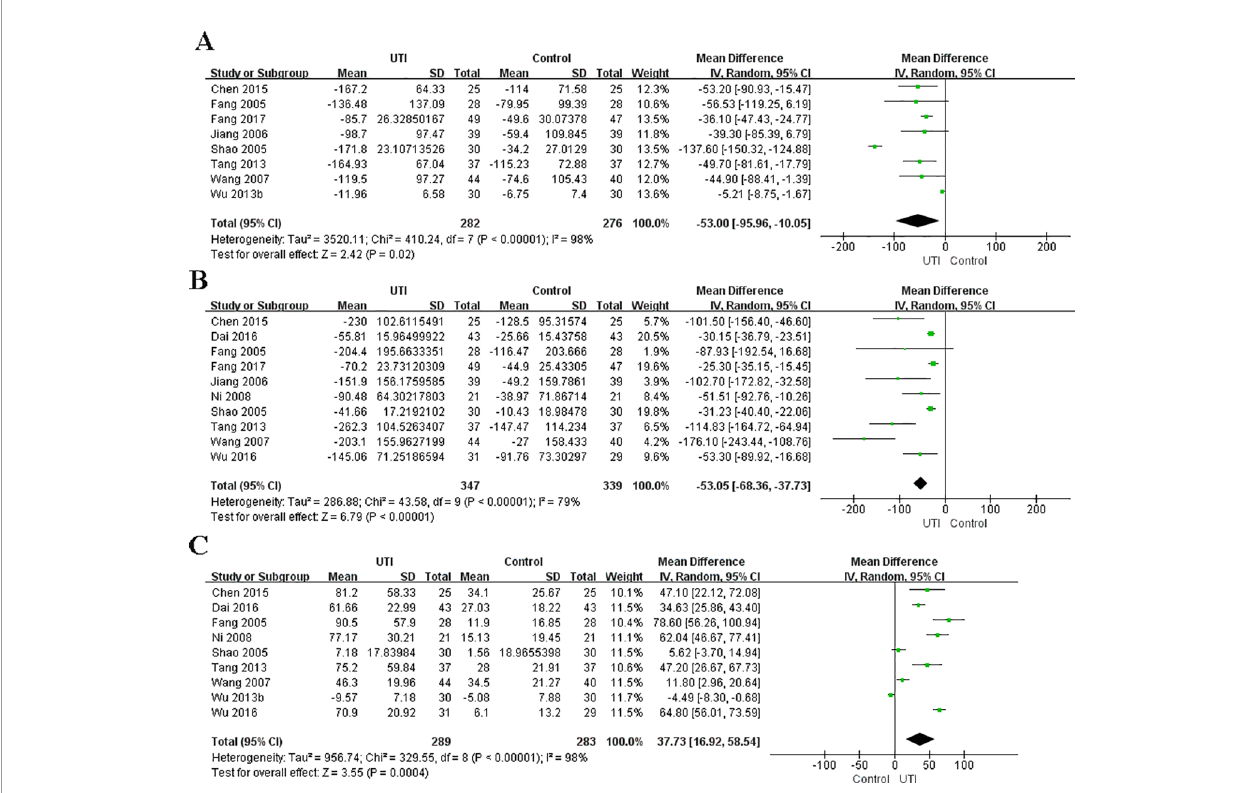
FIGURE 3 | Ulinastatin regulates the levels of pro-in fl ammatory and anti-in fl ammatory cytokines. Pro-in fl ammatory factor: IL-6 (A) , TNF- a (B) . Anti-in fl ammatory factors: IL-10 (C) .